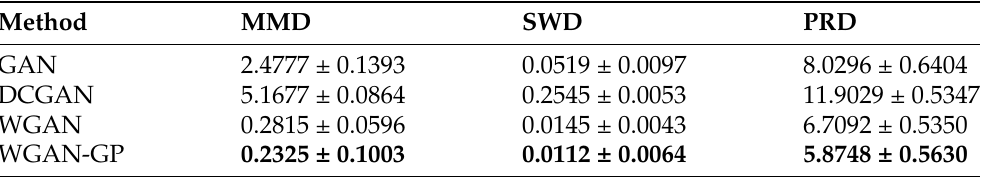
Table 3. Comparison of the metric results (mean value ± standard deviations) for different GAN network architectures (lower is